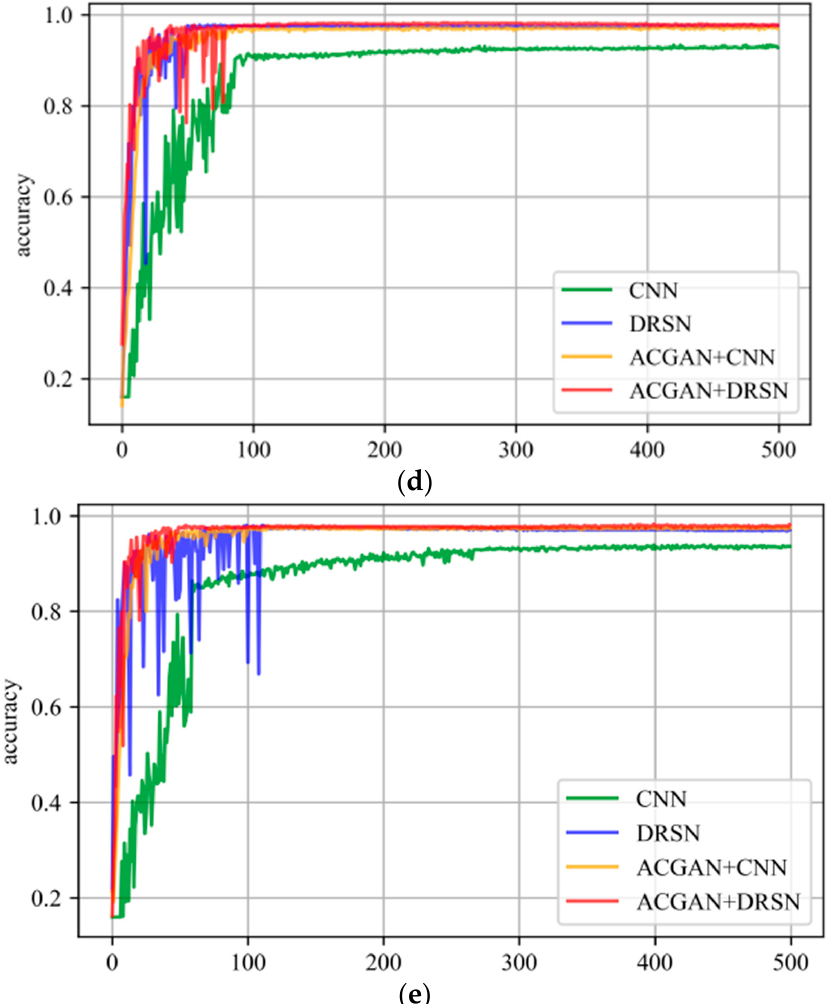
Figure 6. ( a ) Model fault classification accuracy in the condition of − 5 db noise; ( b ) Model fault classification accuracy in the condition of − 2 db noise; ( c ) Model fault classification accuracy in the condition of 0 db noise; ( d ) Model fault classification accuracy in the condition of 2 db noise; ( e ) Model fault classification accuracy in the condition of 5 db noise .